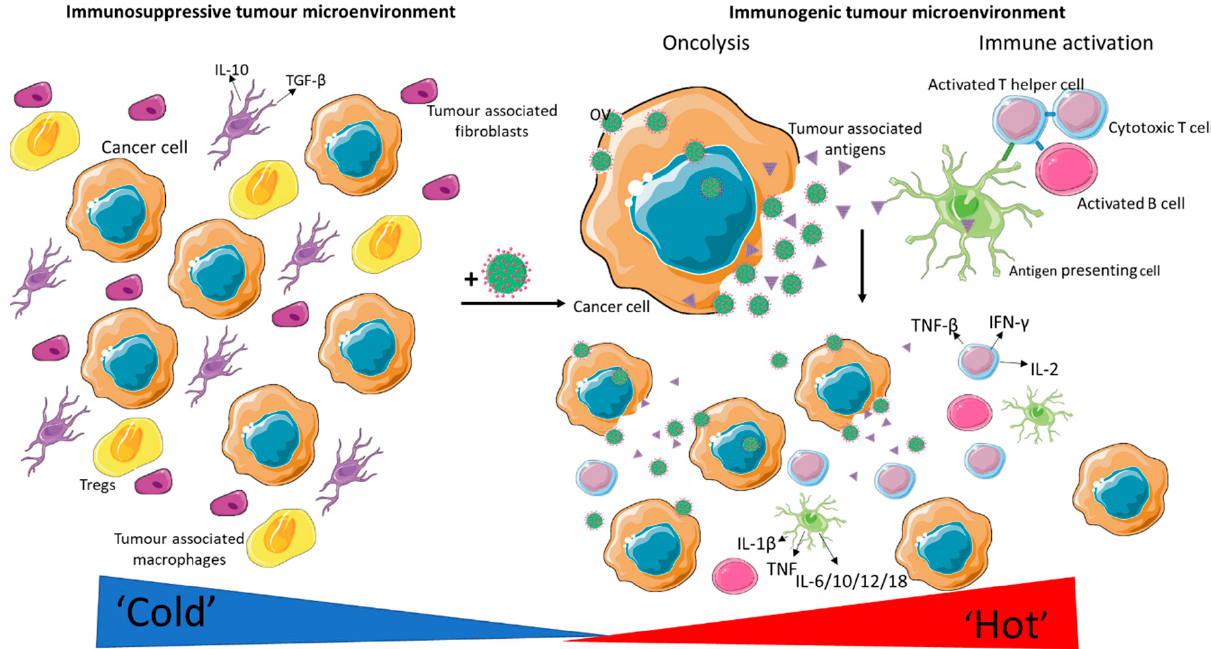
Figure 1. Immunogenic stimulation secondary to oncolytic viruses: Upon viral entry, replication and tumour cell lysis occurs and the innate and adaptive immune systems are activated. The killing of tumour cells via oncolysis releases tumour-associated antigens (TAA) into the circulation. Tumour debris stimulates the activation of resident and circulating antigen-presenting cells, resulting in their maturation. Mature antigen-presenting cells prime both B and T lymphocytes against specific TAAs, leading to long-term immunisation.